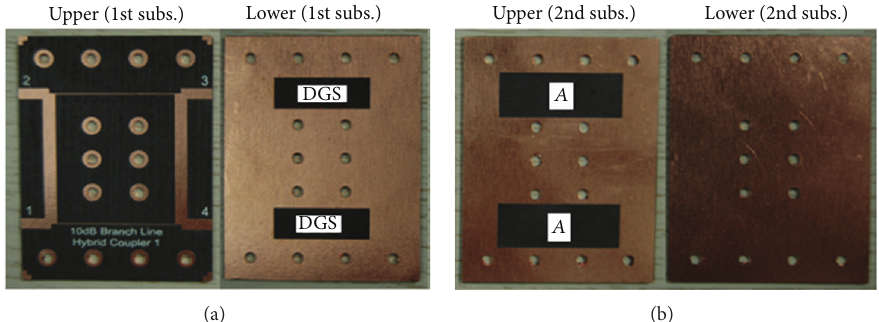
Figure 8: Photographs of the fabricated substrates of 10dB hybrid coupler (a) first substrate and (b) second substrate.